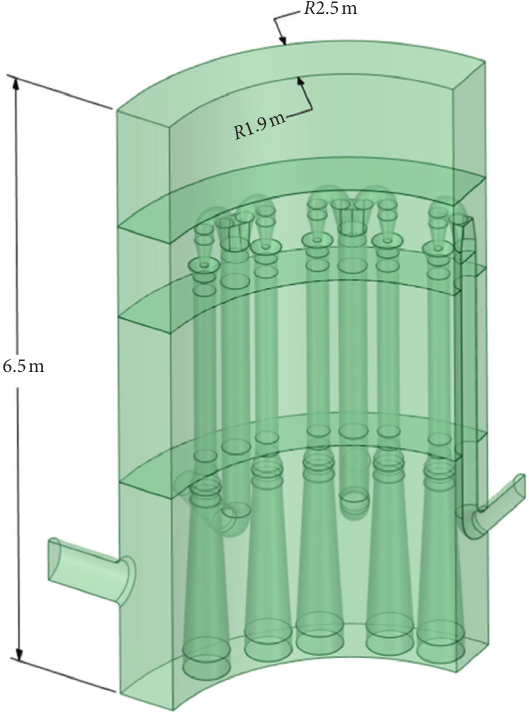
Figure 6: Main dimensions of the volume of control.